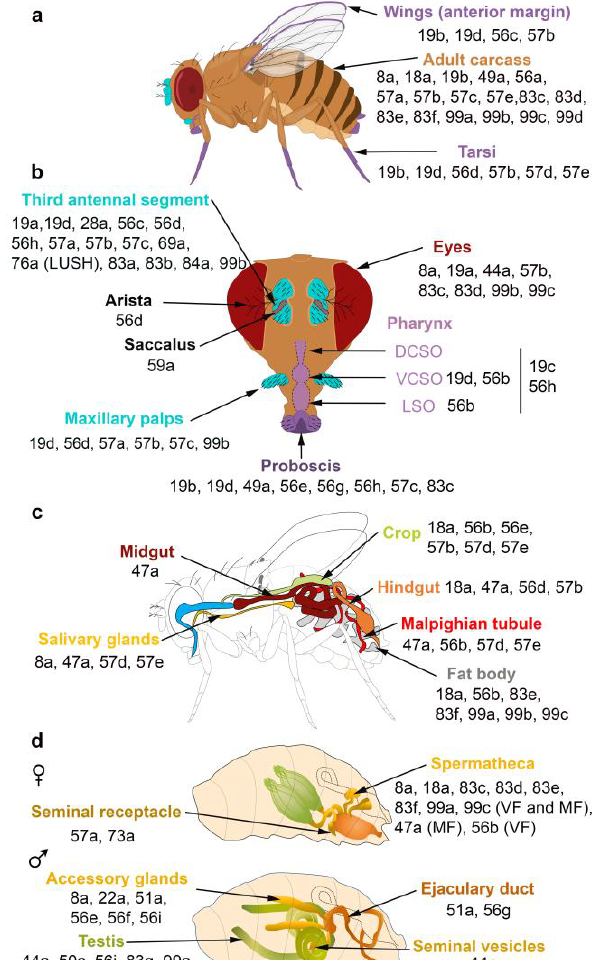
Figure 2. OBPs expressed in the olfactory, gustatory, digestive and reproductive organs of D. melanogaster . ( a , b ) Adult taste organs (purple) consist of the proboscis, the internal structure in the pharynx (the labral sense organ (LSO), the ventral and dorsal cibarial sense organs (VCSO and DCSO)), the leg tarsi, the anterior margin of the wings and the female genitalia. Adult olfactory organs (turquoise) consist of the antenna and the maxillary palps. OBPs expressed in each organ are indicated by their number. OBPs are found in chemosensory and non-chemosensory organs. ( c ) Expression patterns of OBPs in the adult digestive tract. ( d ) Expression patterns of OBPs in the female and male reproductive organs. The expression of OBPs in female spermatheca depends on the sexual state. Some OBPs are expressed in virgin female (VF) and mated female (MF) spermatheca, while the expression of some OBPs is mating-dependent